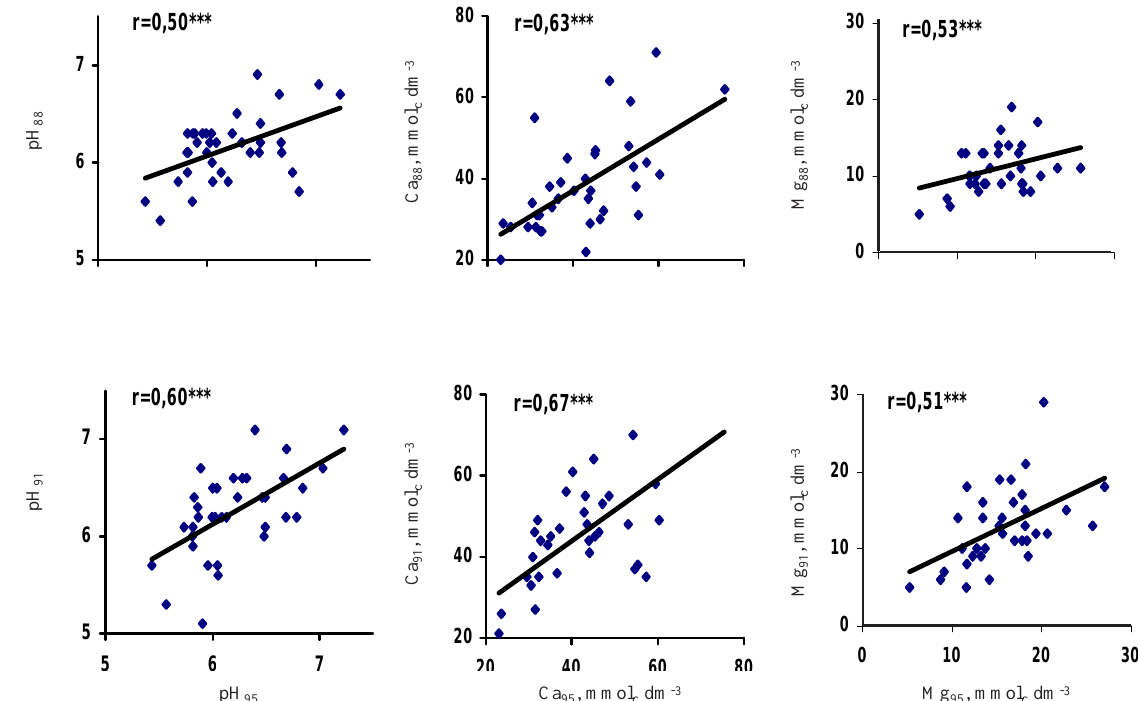
Figura 1. Correlações entre uma mesma característica química do solo (pH, Ca ou Mg) no ano de 1995 com os anos de 1988 e 1991, para 36 talhões de cacau. *** significativo a